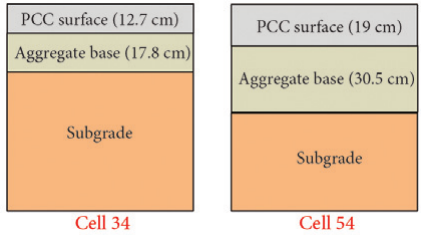
Fig. 1. Schematic cross-section of rigid pavement sections tested (not to